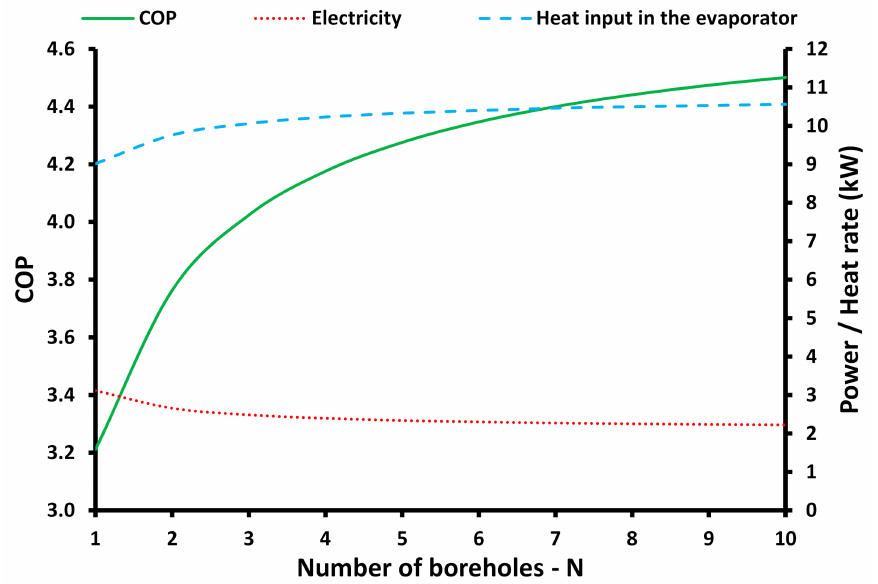
Figure 20. The impact of the number of the boreholes on the COP, electricity consumption and heat input in the evaporator.